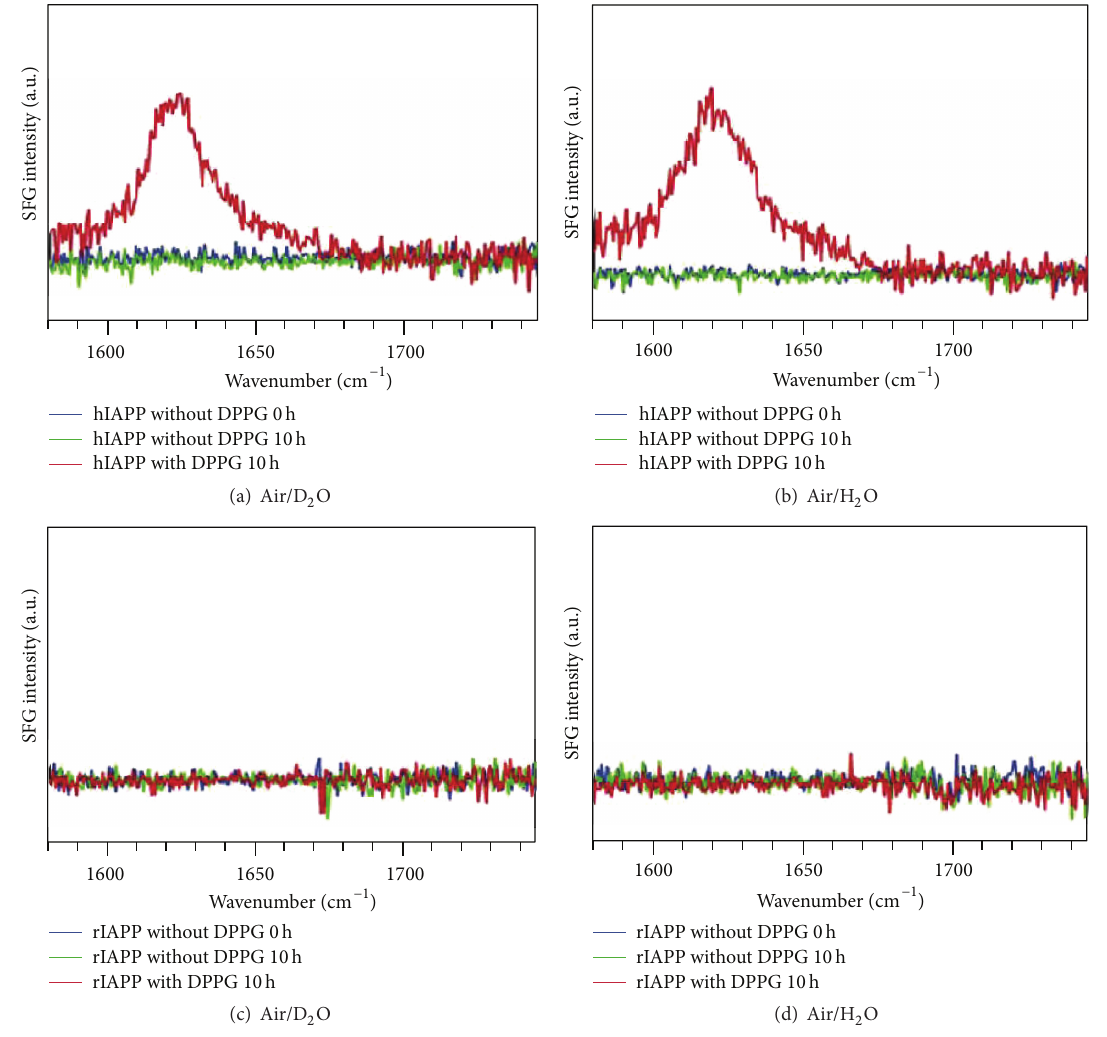
Figure 2: The psp (chiral) SFG spectra of IAPPs. Human IAPP without DPPG ( 𝑡 = 0 h and 𝑡 = 10 h) and with DPPG at 𝑡 = 10 h at the (a) air/D 2 O and (b) air/H 2 O interfaces; rat IAPP without DPPG ( 𝑡 = 0 h and 𝑡 = 10 h) and with DPPG at 𝑡 = 10 h at the (c) air/D 2 O and (d) air/H 2 O interfaces. Adapted from [62] with permission. Copyright 2010 American Chemical